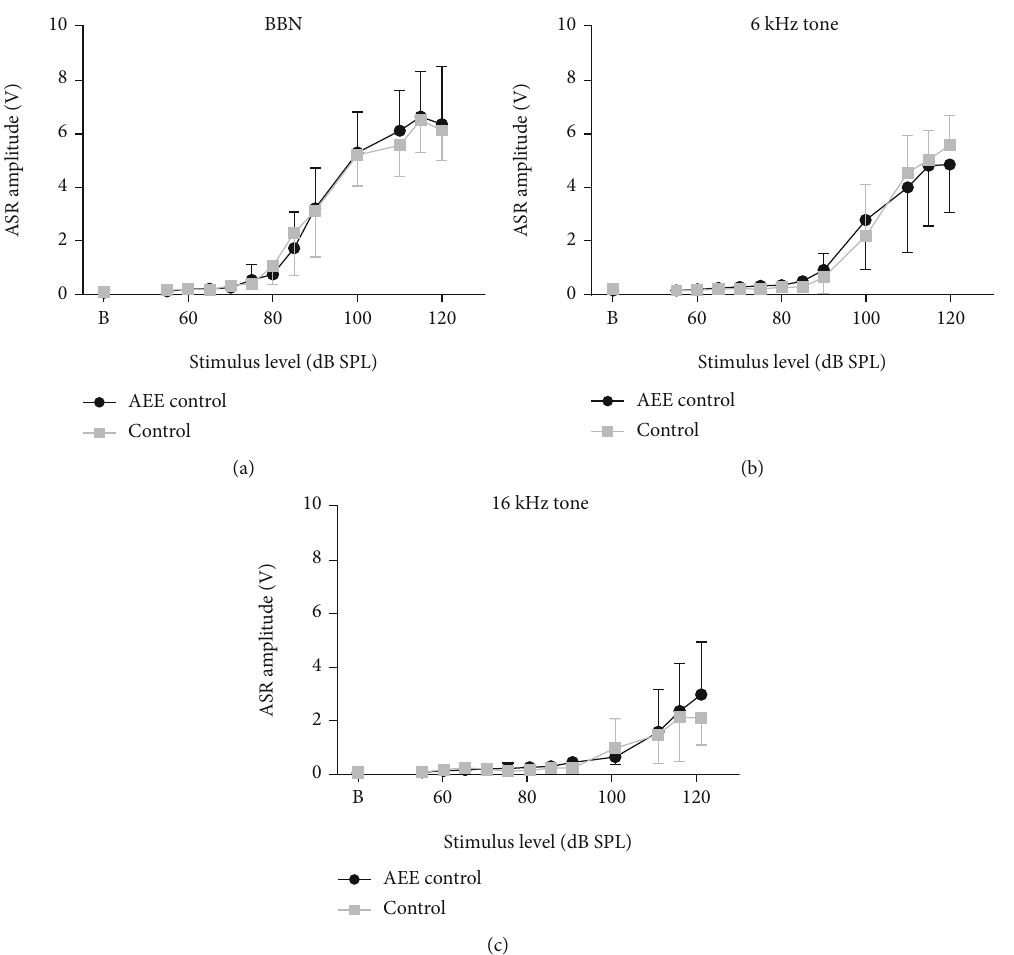
Figure 2: ASR amplitude-intensity functions ( mean ± SD ) obtained for BBN (a), 6kHz (b), and 16 kHz (c) startling pulses in enriched (black) and control (gray) animals. (b) Baseline trial without any acoustical stimulation. The curves in each panel are not statistically di ff erent ( p = 0 : 93 , p = 0 : 96 , and p = 0 : 53 , resp., RM two-way